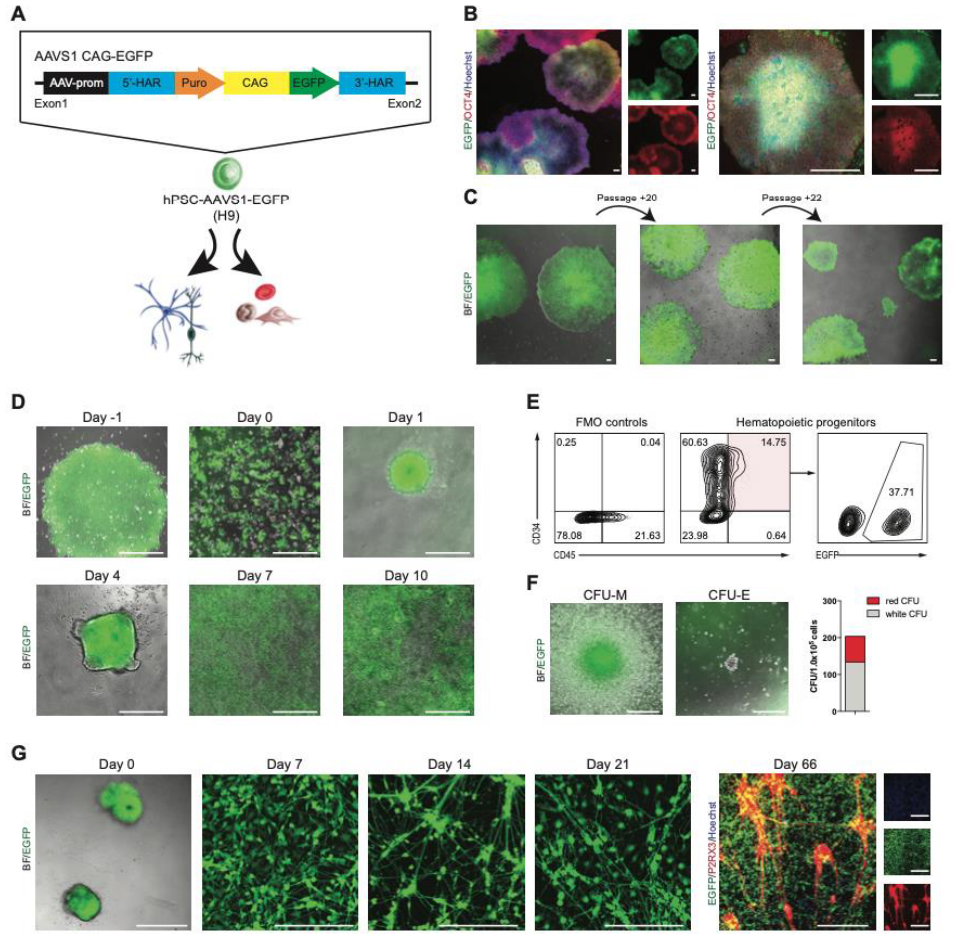
Figure 3. Hematopoietic and neural differentiation of hPSC–AAVS1–EGFP. ( A ) Experimental ap- proach for the generation of EGFP knock-in hPSC lines, and illustration of the AAVS1 EGFP reporter allele. 5 (cid:48) -HAR/3 (cid:48) -HAR, upstream/downstream homology arm; puro, puromycin; CAG, CAG pro- moter. ( B ) Immunofluorescence images of undifferentiated hPSC–AAVS1–EGFP colonies, cultured in feeder-free conditions in mTeSR medium, exhibiting typical cell morphology, and expressing OCT4 (red) and EGFP (green). Nuclei are stained with Hoechst (blue); scale bars = 80 µ M and 240 µ M, respectively. ( C ) Microscope images showing colony morphology and marker expression of hPSC–AAVS1–EGFP cultures after induction and FACS over time with stable EGFP expression. ( D ) Phase-contrast and immunofluorescence images of differentiating hPSC–AAVS1–EGFP cells; scale bars = 240 µ M. ( E ) Flow cytometry of total (CD34 + /CD45 + ) and EGFP + hematopoietic progenitors. ( F ) Microscopic images show different colony types in methylcellulose assay; scale bars = 200 µ M. Bar graph indicates colony-forming activity; n = 1. ( G ) Phase-contrast and immunofluorescence images of sensory neural (PNS) differentiation of hPSC–AAVS1–EGFP from EB formation (day 0) through sensory neural maturation until day 66. Cultures were stained positive for EGFP (green) and for PNS-specific purinergic receptor (P2RX3, red). Nuclei were stained with Hoechst (blue); scale bars = 240 µ